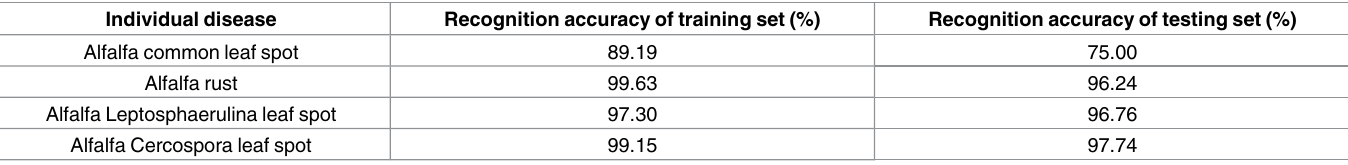
Table 7. Recognition results of each alfalfa leaf disease using the optimal model (Model 4). Individual